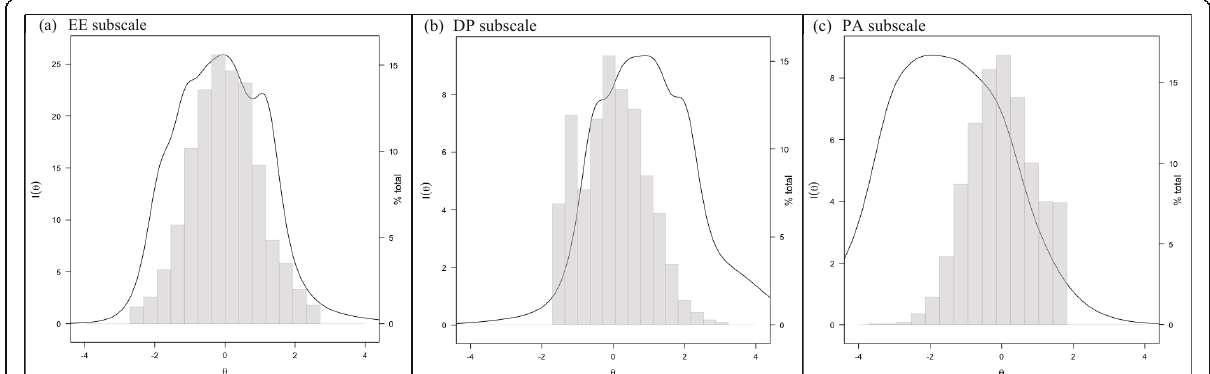
Fig. 1 Emotional Exhaustion (EE), Depersonalization (DP), and Personal Accomplishment (PA) Subscale Test Information Functions (TIF) Relative to US Physician Sample Score Distribution a . a (I ∣ θ ) of 3.33, 10, and 20 is approximately equal to 0.70, 0.90, and 0.95 reliability, respectively. θ refers to the underlying metric for each MBI subscale and corresponds with IRT z-scores. US physicians ’ z-scores are distributed from − 2.51 to 2.51, − 1.52 to 3.05, and − 3.51 to 1.62, on the EE, DP, and PA subscales,